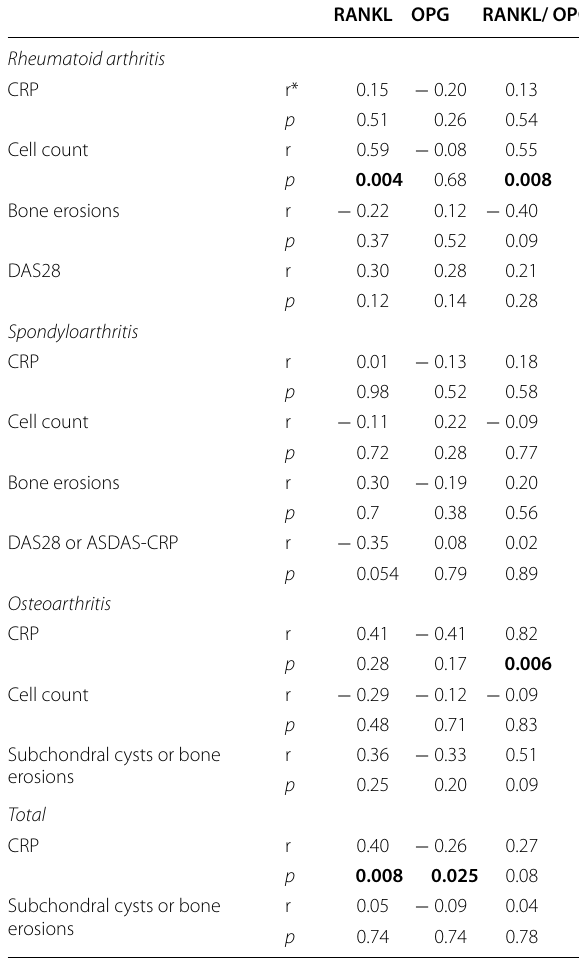
Table 3 Correlations of RANKL, OPG and RANKL/OPG with laboratory and radiographic